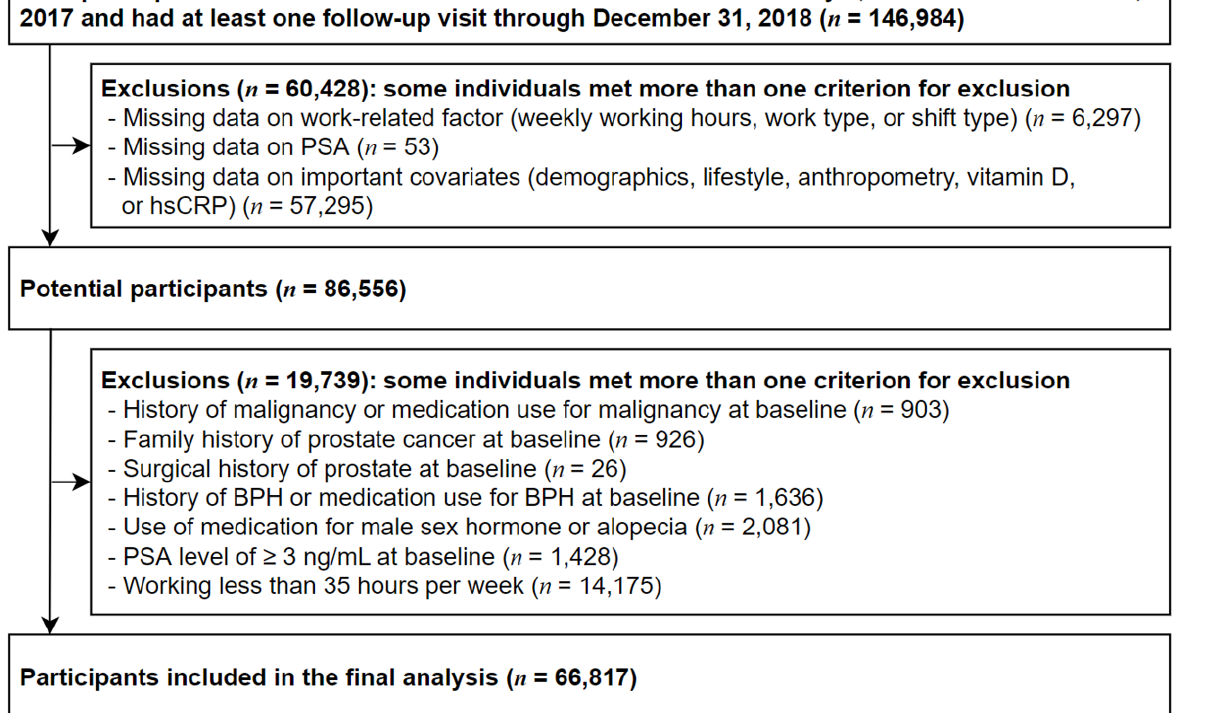
Figure 1. Flowchart of study participants (PSA, prostate-specific antigen; hsCRP, high-sensitivity C-reactive protein; BPH, benign prostatic hyperplasia).